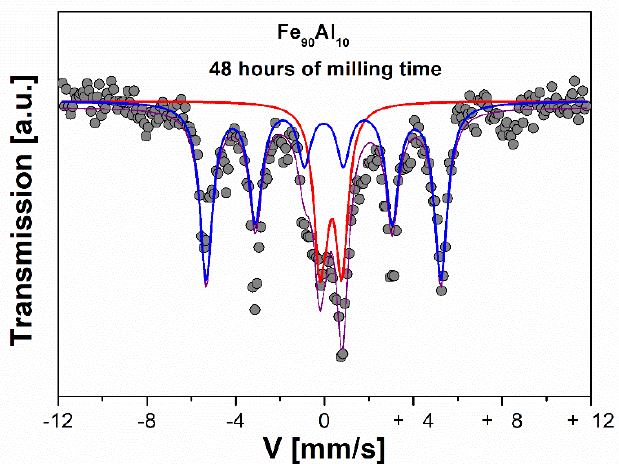
Table 2. Mössbauer parameters and probability distribution of the Fe 90 Al 10 system with thermal treatment at 1000 ◦ C for 7 days and 48 h of milling with oleic acid as a surfactant (the column with ( δ ) corresponds to the isomer shift values; the column with ( Γ ) corresponds to the line widths; the column with ( Qs ) corresponds to the quadrupole splitting; the column with (HF) corresponds to the hyperfine field; and the line with (HMDF) corresponds to the magnetic hyperfine field distribution).